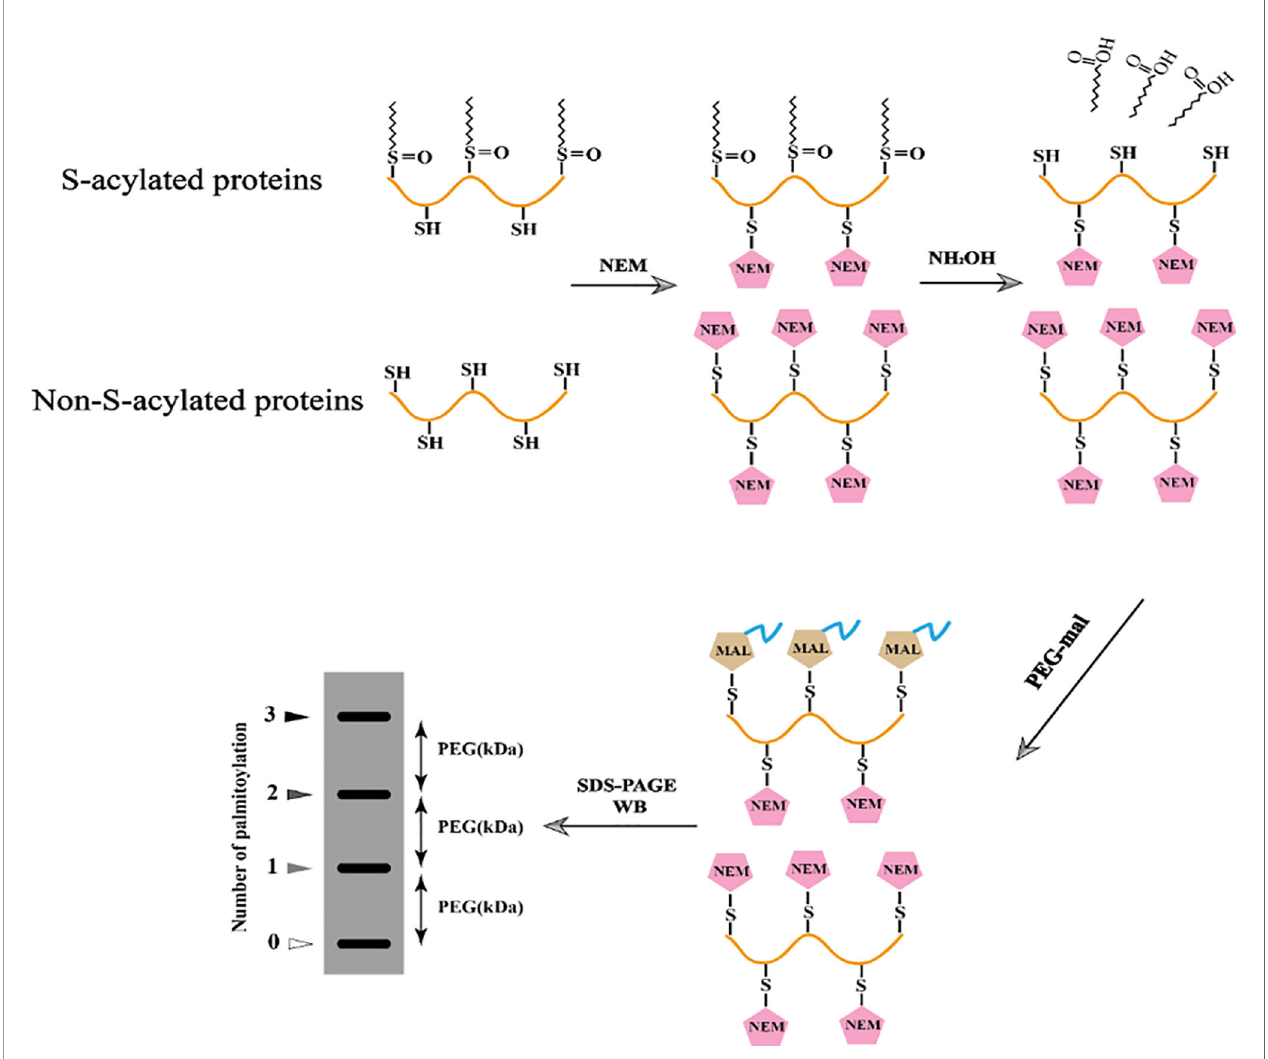
FIGURE 2 | Schematic diagram of Acyl-PEGyl exchange gel-shift (APEGS)